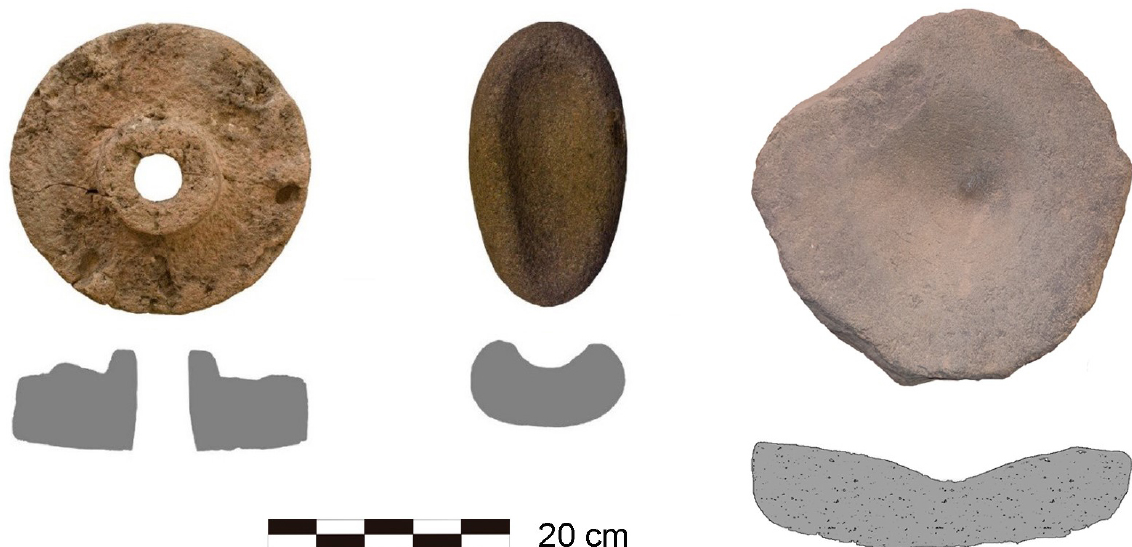
Figure 2. Examples of the types of grinding stones from the Island of Gran Canaria (rotary quern, El Pajar- Arguineguín; “saddle quern”, Cenobio de Valerón-Santa María de Guía; mortar, Cueva Pintada-Gáldar). The scale bar is 30 cm (6 cm